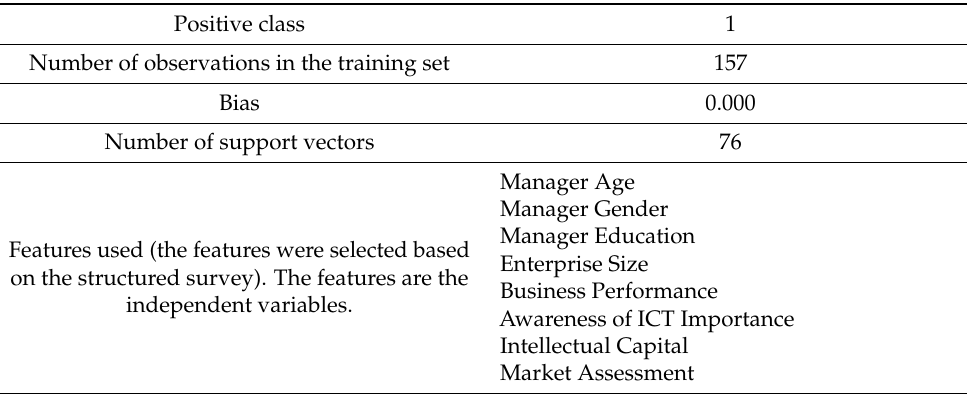
Table 7. Summary of the optimized SVM classifier.